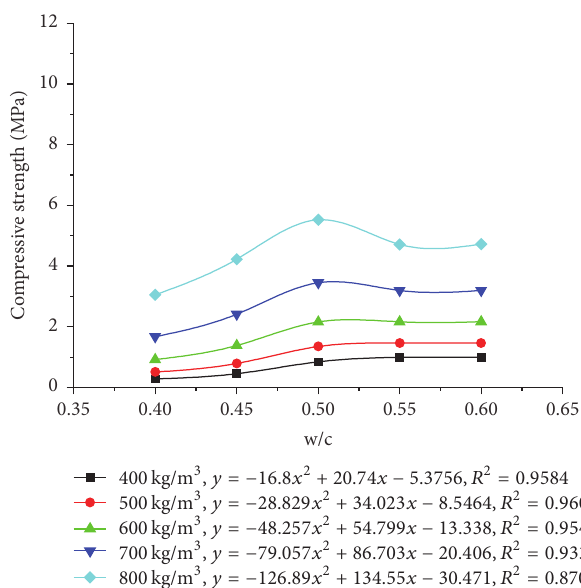
Figure 7: Effect of w/c ratio on the strength of foam concrete.